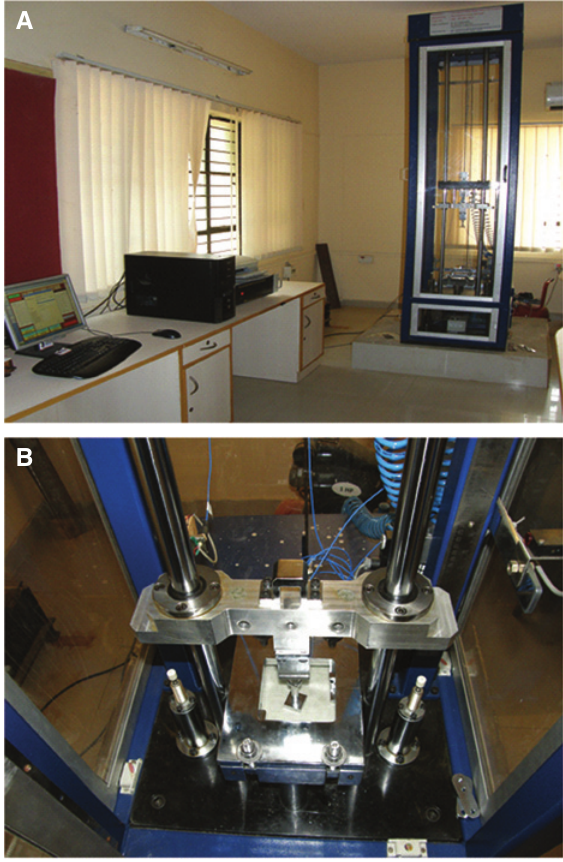
Figure 3 Low velocity impact test setup. (A) Instrumented falling weight impact testing machine. (B) Specimen clamping fixture.